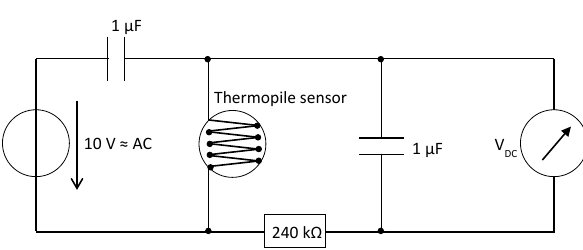
Figure 2. Electrical circuit for driving the thermopile as gas sensor. Inner resistance of the sensor is 120k (cid:127)